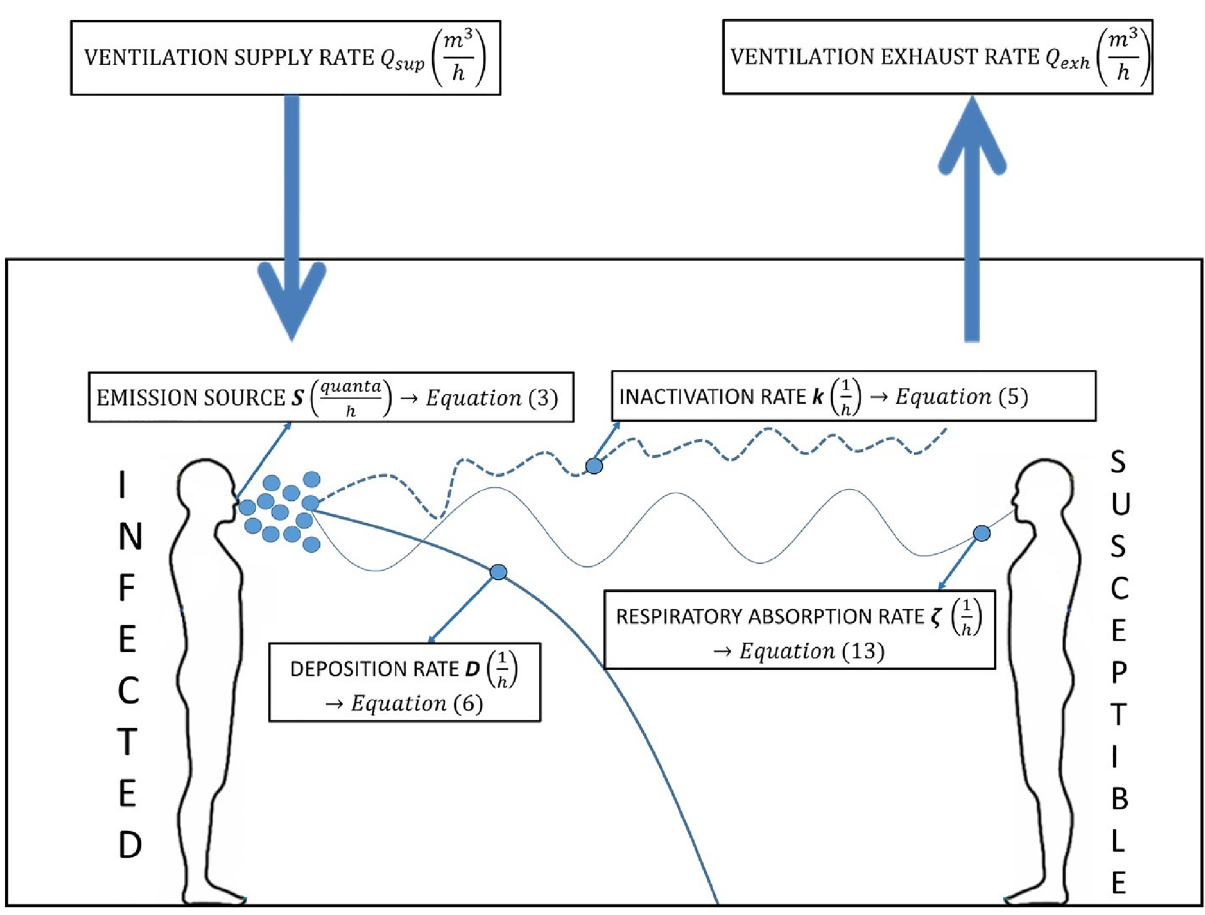
Figure 3. Schematic representation of a simple completely mixed indoor environment including a source term S and removal mechanisms by ventilation, virus inactivation k, deposition by gravitational settling D, and respiratory absorption ζ